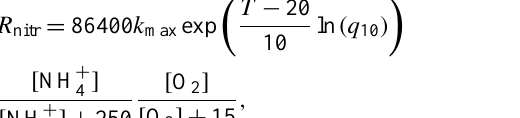
Table 1. Stoichiometric coefficients for the proton ( ν x ) for each reaction considered in the proton budget. c 2 and c 3 are the ratios of HCO − H + and CO 2 − to DIC, na 1 and na 2 are the ratios of HNO 3 and NO − to total nitrate, n 1 is the ratio of NH + 3 3 are the ratios of H 2 PO − , HPO 2 − and PO 3 − to total phosphate, 4 4 4